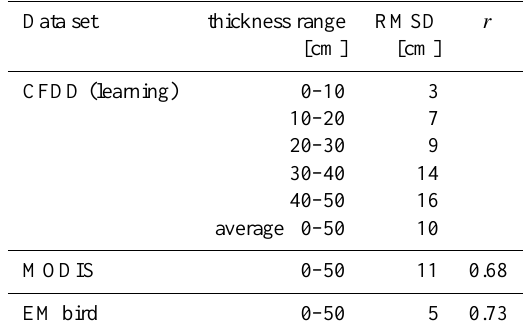
Table 2. Retrieval characteristics from learning and independent validation data sets. r correlation